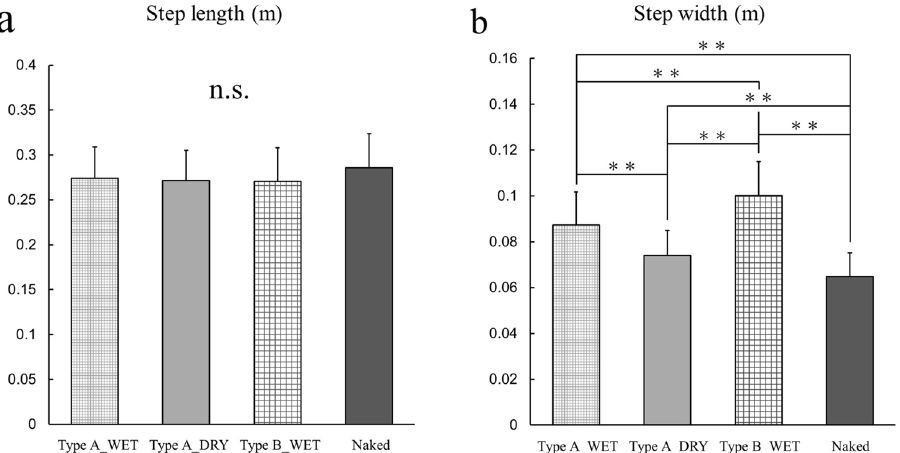
Figure 3. Mean and standard deviation of the mean of the normalized ( a ) step length and ( b ) step width for the four dress conditions. *p < 0.05; **p <